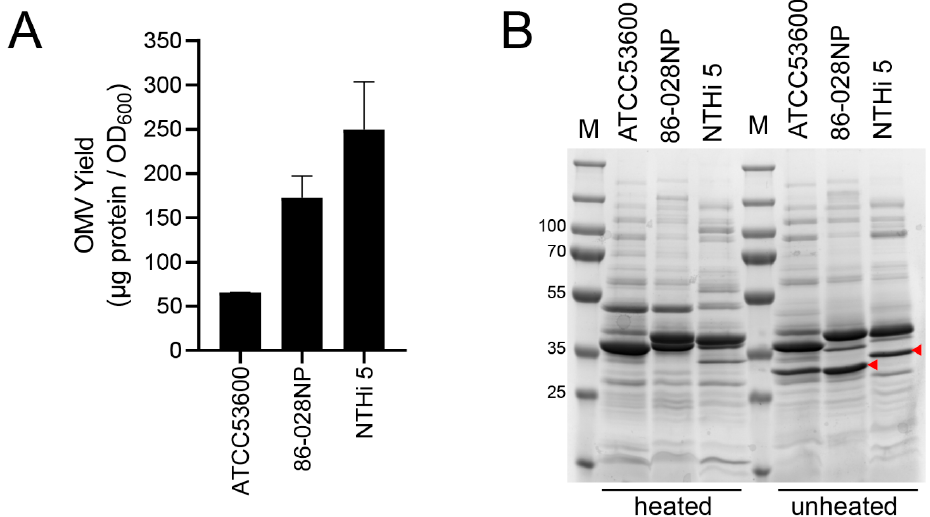
Figure 1. ( A ) OMV yield as measured by protein concentration obtained from three different NTHi strains using the protocol described above. Bars represent Mean ± SEM, n = 3. ( B ) Tris-Glycine SDS-PAGE analysis of the protein profile of OMVs isolated from the indicated NTHi strain. Heated samples were boiled at 100 °C for 10 min, while unheated samples remained at room temperature. A total of ~10 μ g protein was loaded onto each well. Red arrowheads indicate the position of the heat-modifiable OmpP5.